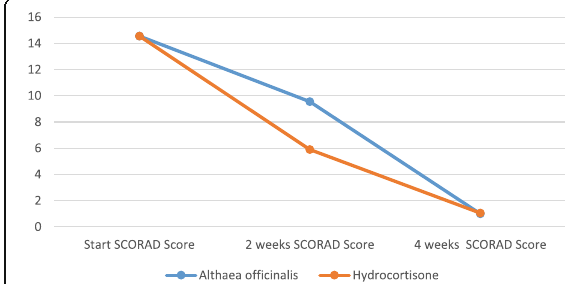
Fig. 2 Improvement from baseline in mean scoring of Atopic Dermatitis (SCORAD) Althaea Officinalis compared with Hydrocortisone acetate ointment (1 %) or